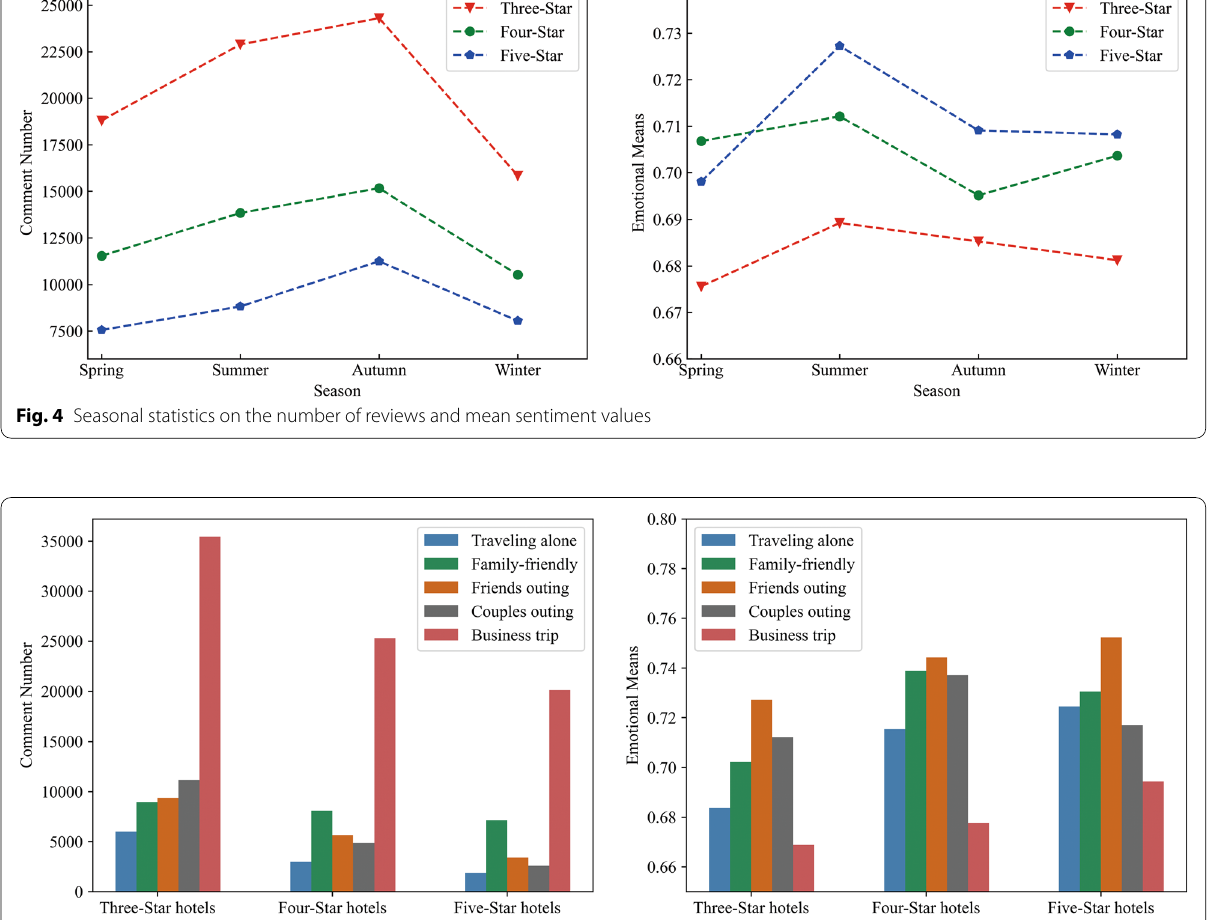
Fig. 5 Average number of people and emotions of different star travel